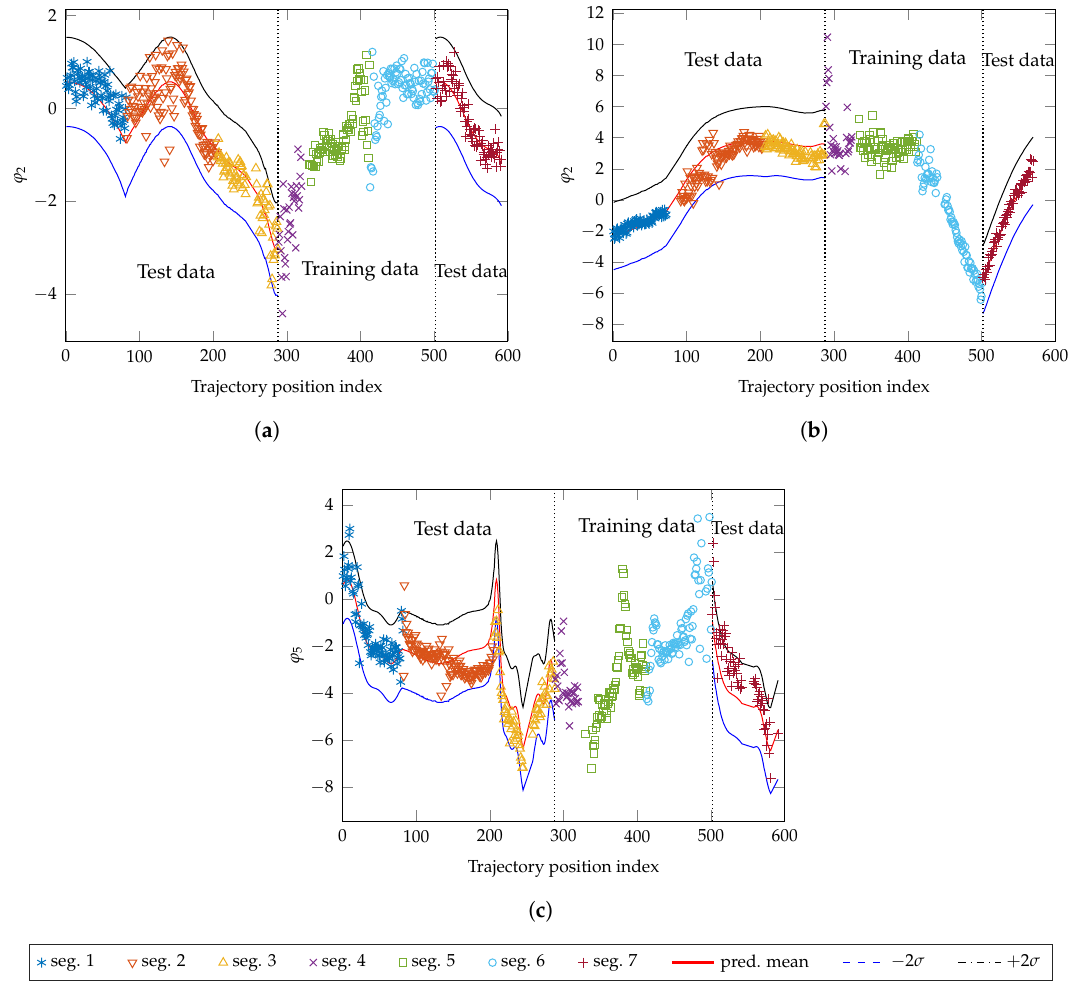
Figure 7. GP prediction of the SMC phases for ( a ) the SMC amplitude of VA at a ( 1 ) anchor 1 (east plaster board wall), ( b ) the SMC amplitude of VA at a ( 2 ) plaster board wall), ( c ) the SMC amplitude of VA at a ( 1 )